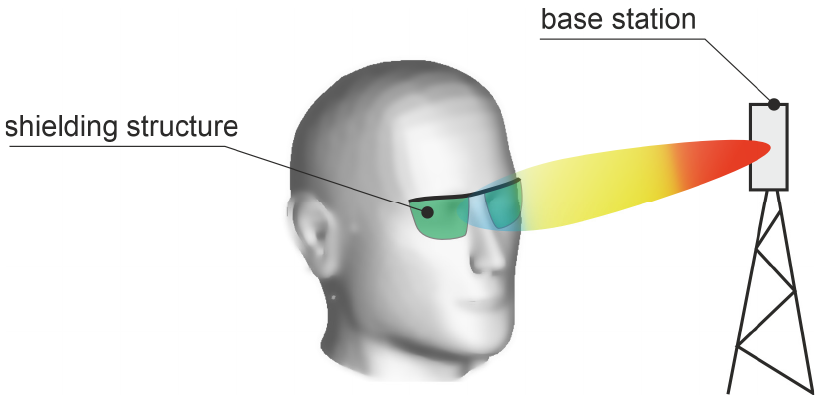
Figure 1. The concept of the eye-protective shielding structure.